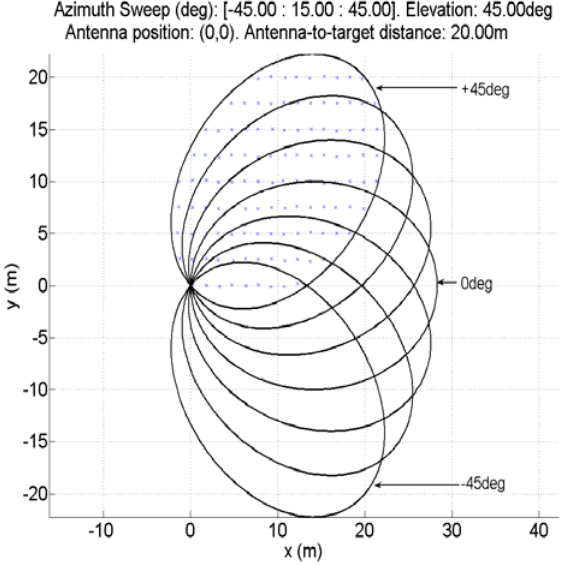
Figure 8. Field-Of-View of the antenna footprints for azimuthal angles from -45° to +45° in 15° steps (incidence angle equal to